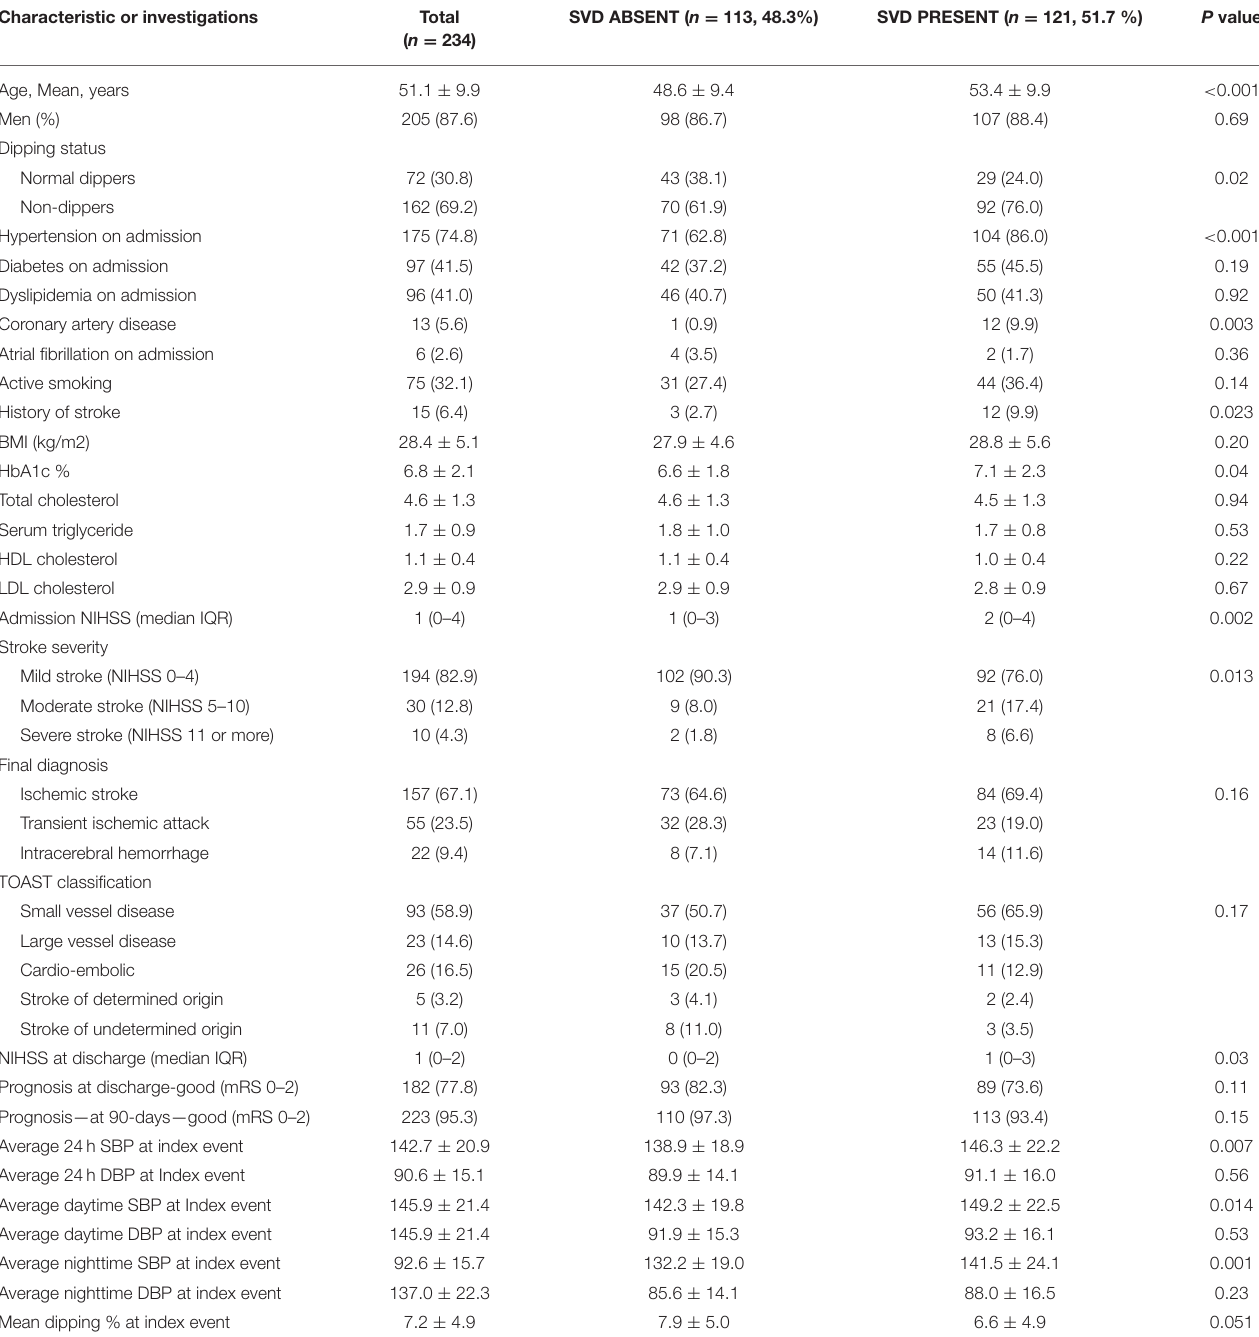
TABLE 2 | Demographics, risk factors, clinical presentation, severity of symptoms at presentation, short-term prognosis in patients with and without small vessel disease (SVD). Characteristic or